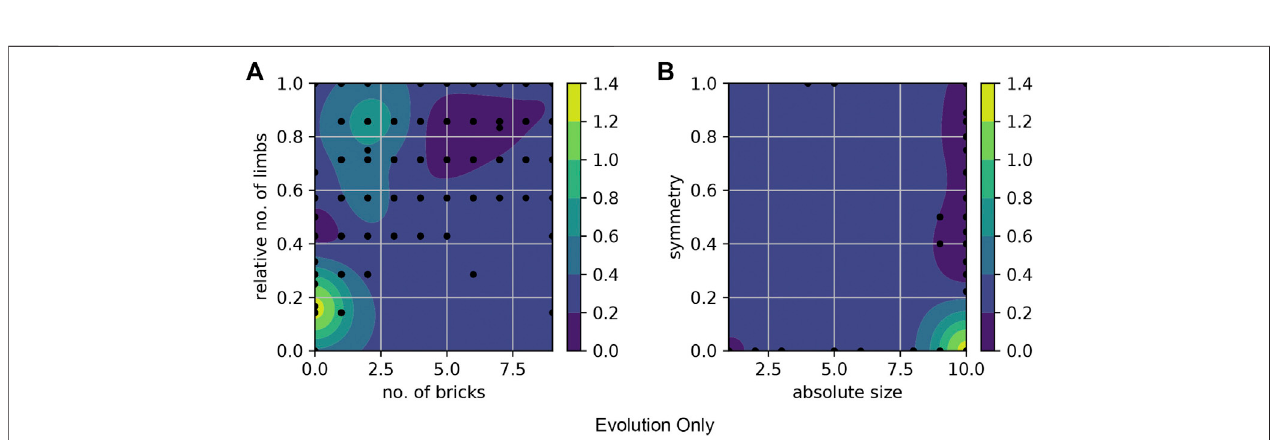
FIGURE11 | Fitness landscape ofEvolution-Only using pairs ofmorphologicalmeasurements ascoordinates. Thecolor bars show the fi tnesslevel. (A) shows the fi tness landscape of number of bricks over relative number of limbs, the robots with higher fi tness values are in the morphological spaces of fewer bricks and limbs. (B) showsthe fi tnesslandscapeofabsolutesizeoversymmetry.Therobotswiththehighest fi tnesshaveamaximumabsolutesizeof10,however theyarenotsymmetrical.